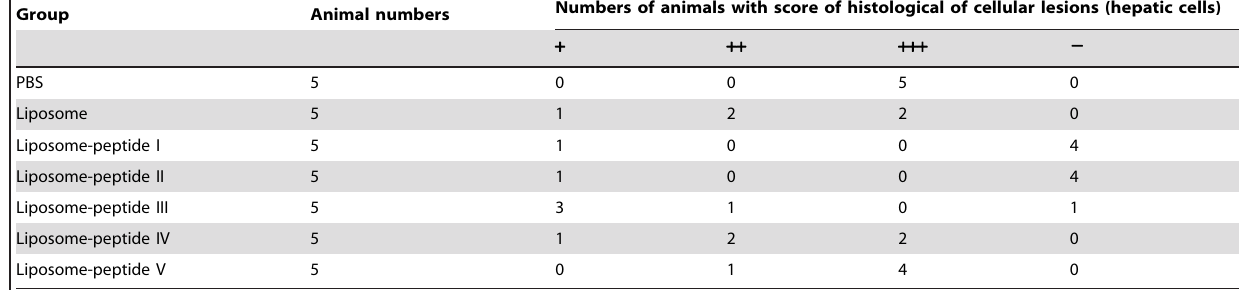
Table 4. Histological changes in seven groups.